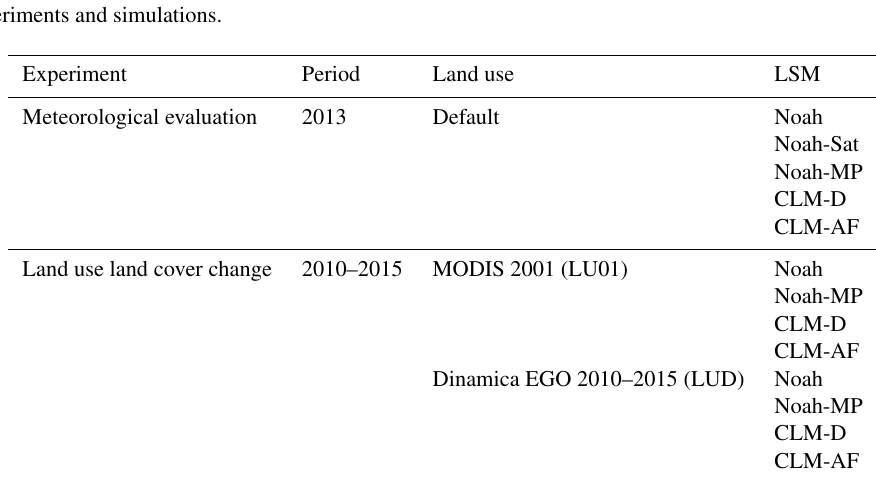
Table 7. Model experiments and